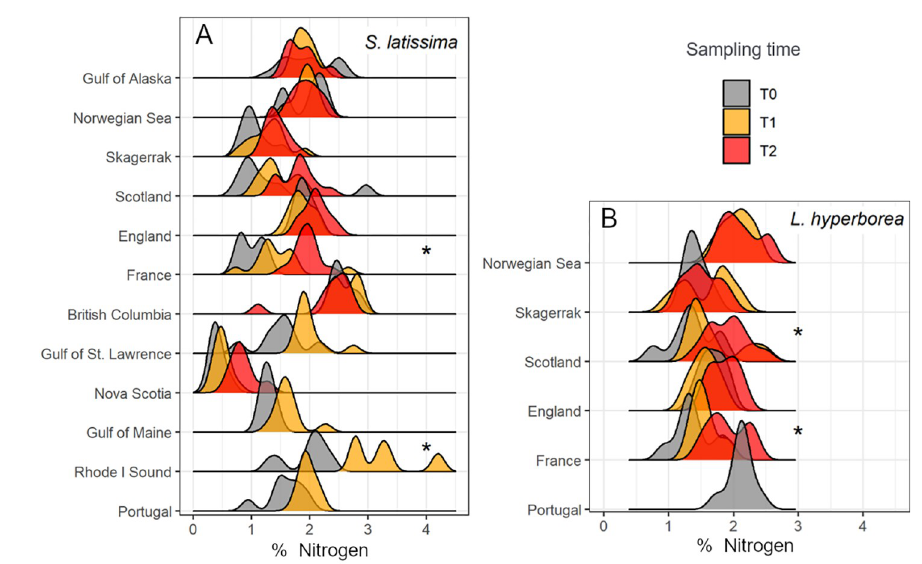
Fig 5. Change in detritus quality with decomposition. Total nitrogen content in kelp detritus over the experiment for Saccharina latissima and Laminaria hyperborea . Data are frequency measures of % nitrogen from tissue samples taken at the onset of the experiment (T0), the first sampling time (T1), and the final sampling (T2). Y axes units are the proportion of observations. Measures are pooled across sites for each region and ordered by decreasing latitude. Values are missing for later samplings in some regions because insufficient biomass remained for analysis at the time of sampling ( � denotes statistical significance, post hoc tests in S4 Table, Data B in S1 Data).